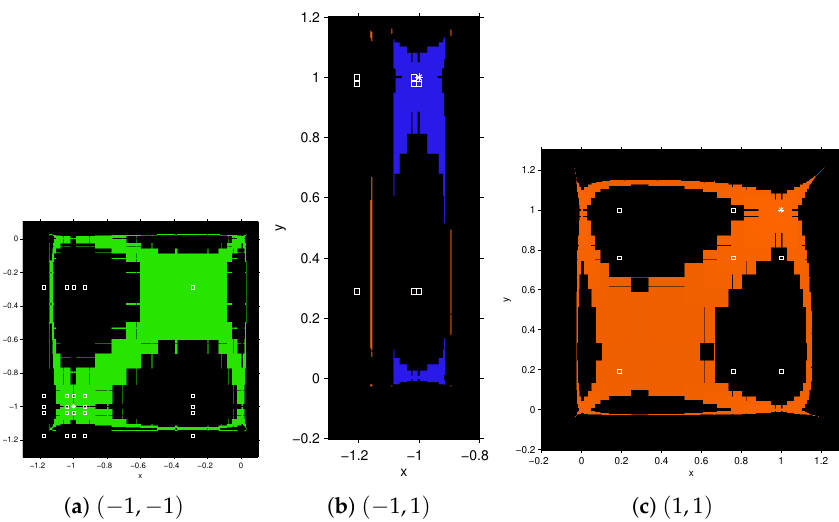
Figure 4. Basins of attraction of ( − 1, − 1 ) , ( − 1,1 ) and ( 1,1 ) for FMN 2 method on r ( x ) . Green, orange, red and blue areas are the basins of attraction of the roots of q ( x ) (marked as white stars); black area denotes divergence and white squares are free critical